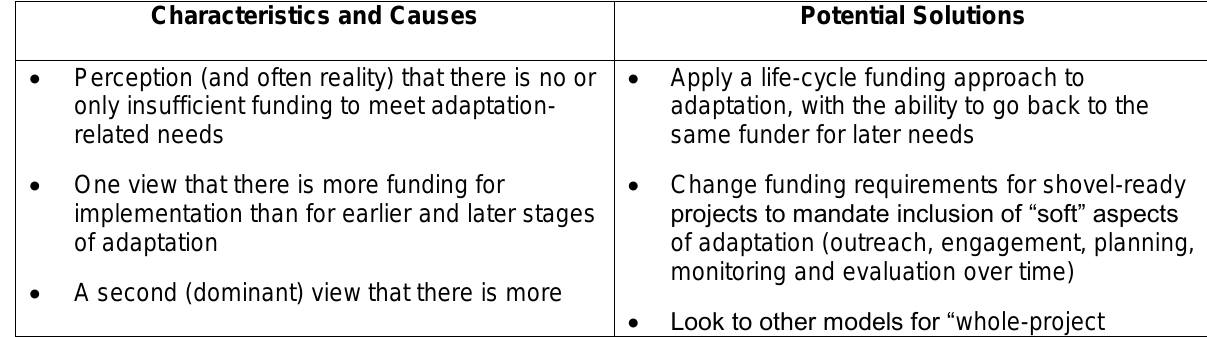
Table A2.13: Characteristics, Underlying Causes and Potential Solutions to